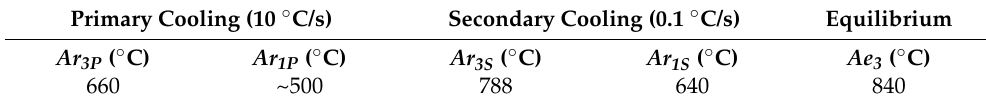
Table 2. Measured critical temperatures during primary and secondary cooling